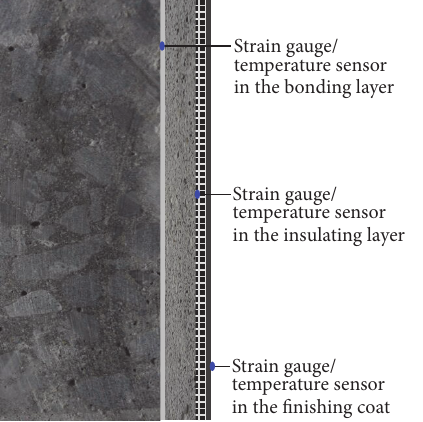
Figure 3: Strain gauges and temperature sensors profiles in the vertical